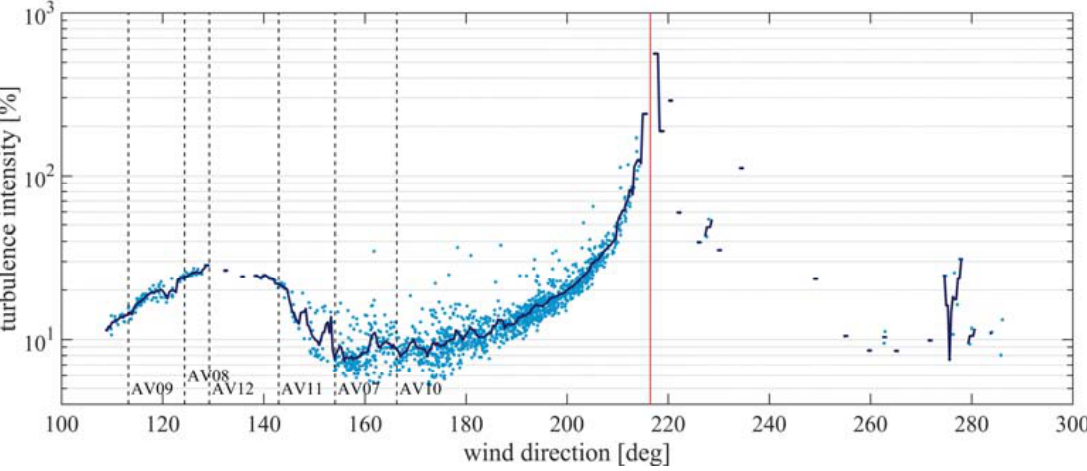
Figure 7. Visualisation of the line-of-sight velocity turbulence intensity in dependency of the wind direction measured by the ultrasonic anemometer from 21.12.2013 15:35h (UTC) till 19.01.2014 7:55h (UTC). Gaps in the plot visualise unavailability of anemometer data. Individual 10 min mean values are shown in light blue whereas the binned averaged is marked in dark blue. Black vertical dashed lines indicate the wind direction of possible wake shading of the anemometer on FINO1 based on geometrical correlations. The red line shows the perpendicular wind direction to the azimuthal orientation of the laser beam.